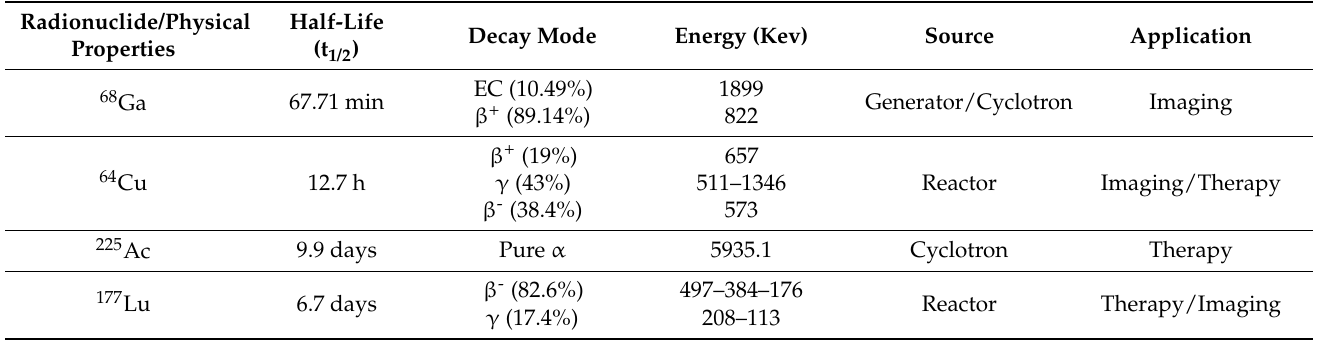
Table 1. Physical characterization of common radionuclides with clinical applications for diagnostic or therapeutic purpose of